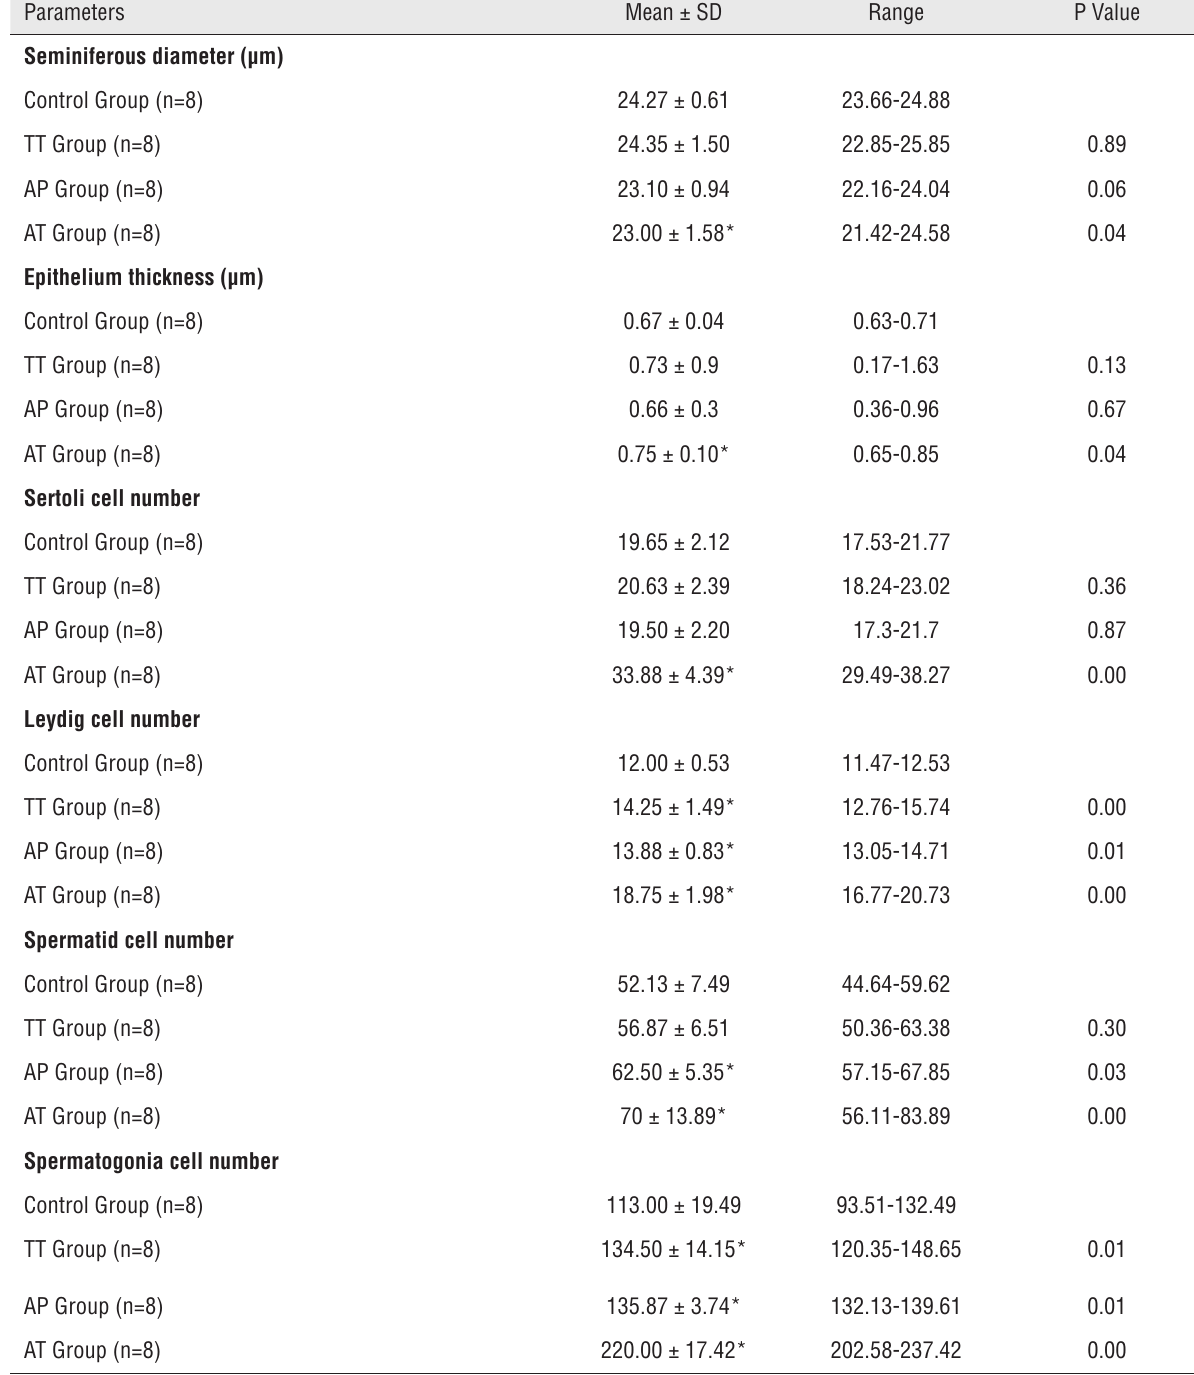
Table 2 - Seminiferous diameter, epithelium thickness and Sertoli, Leydig, spermatid, spermatogonia cell numbers taken in this study (mean ±